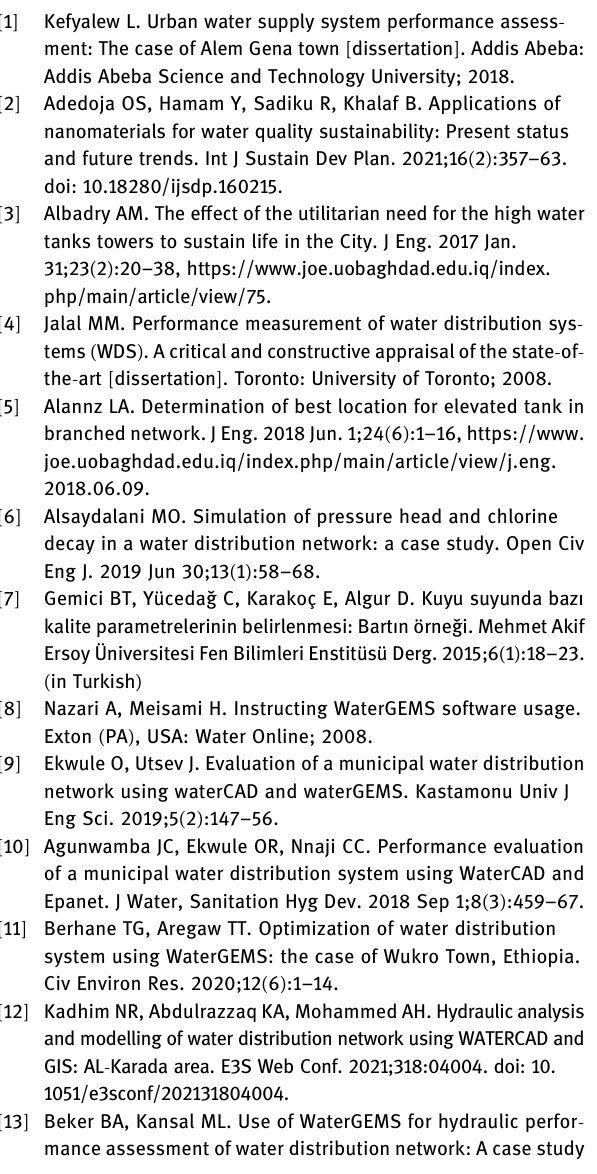
Figure 13: Ranges of residual chlorine calculated in the